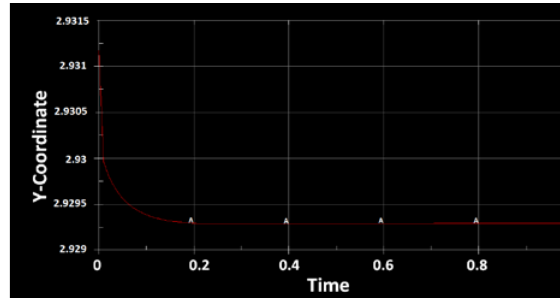
Figure 7: Vertical Y-displacement of element no. 7202 before springback